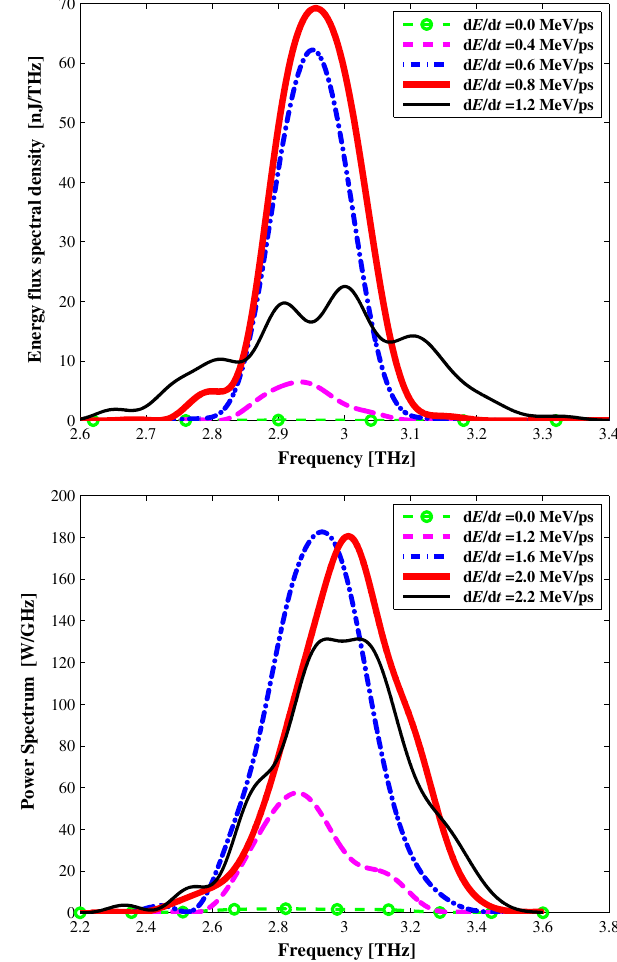
FIG. 3. Radiation spectrum emitted in the ECSE FEL. The bunch charge Q b ¼ 30 pC (top) or Q b ¼ 300 pC (bottom), and the bunch duration f s T b ≈ 1 . Random Gauss initial distribution of N q ¼ 300 charged